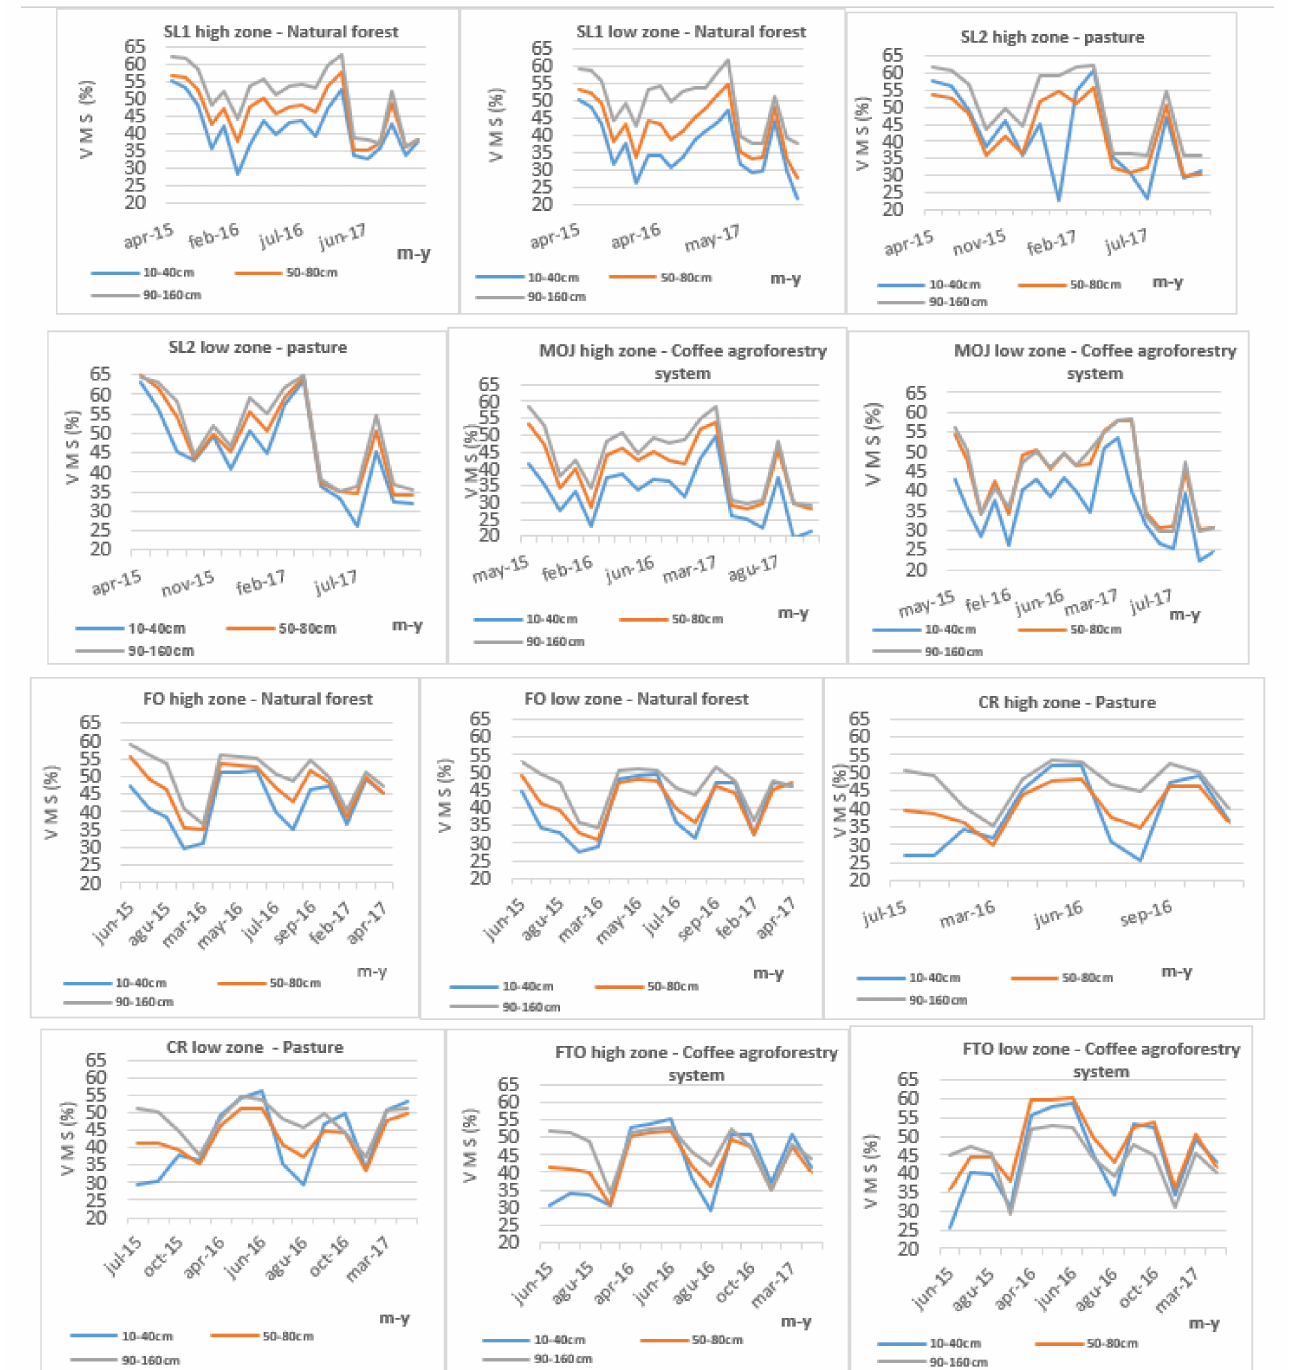
Figure 5. Behavior of the average volumetric soil moisture (VMS) from the high-zone, low-zone and depth ranges 1 (20–40 cm), 2 (50–80 cm) and 3 (90–160 cm), at the microbasin SL1, SL2, MOJ, Combeima River basin and FO, CR, FTO, Cali River